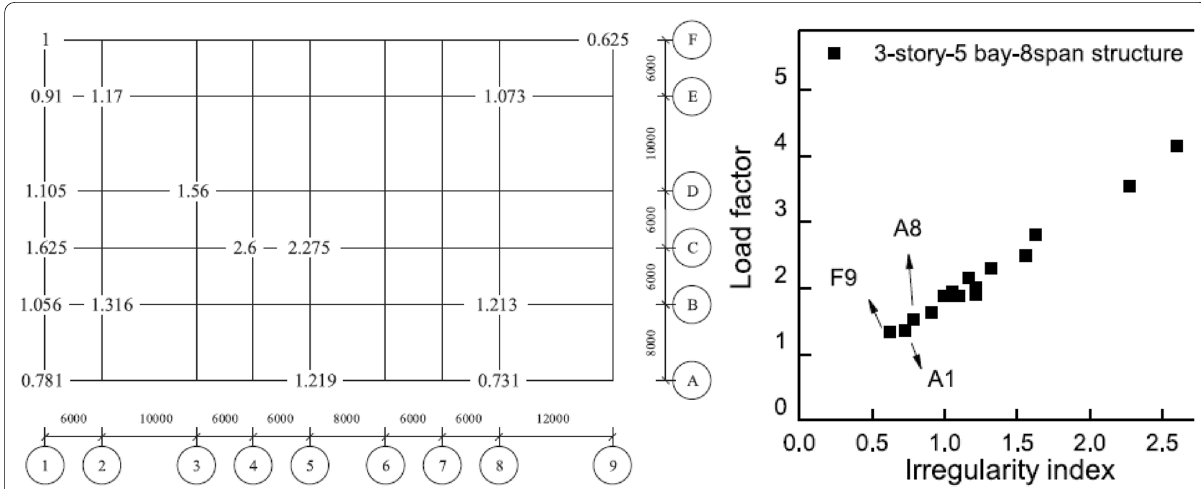
Fig. 4 The weakest column removal location of regular planar frames: comparison between irregularity index (left) and FEA results (right). Image by courtesy of He (Hunan